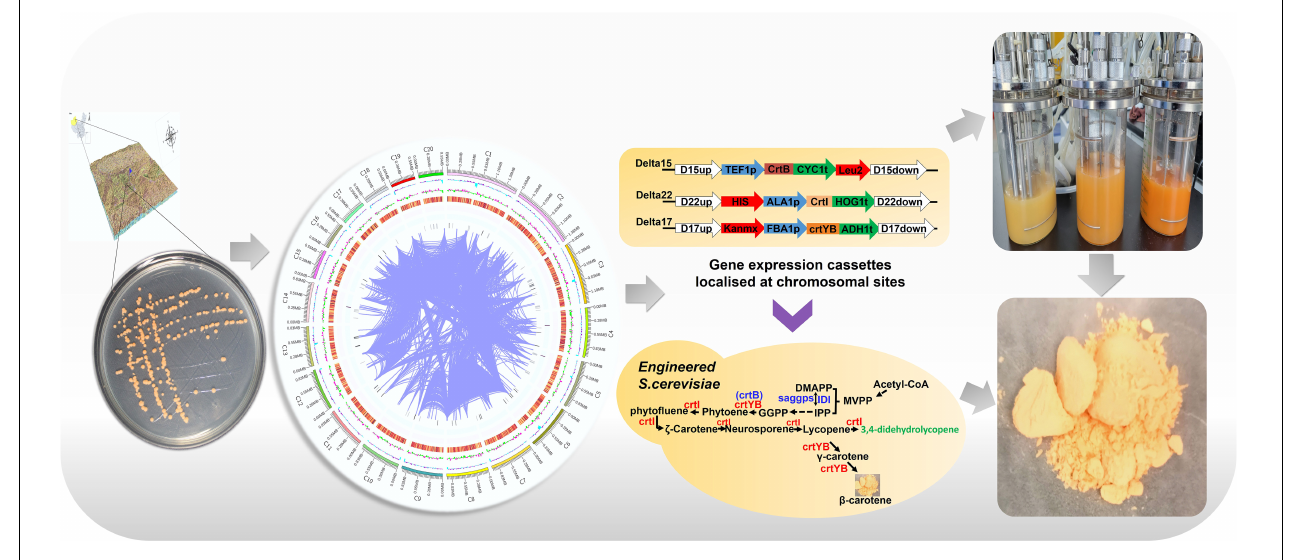
including monounsaturated fatty acids (C18:1), saturated fatty acids (C16:0) and polyunsaturated fatty acids (C18:2) (4, 5). Carotenoids are another important product from R. glutinis . For example, R. glutinis from the beer wastewater with high concentration of sugar (24.34 g · L − 1 maltose and 5.77 g · L −